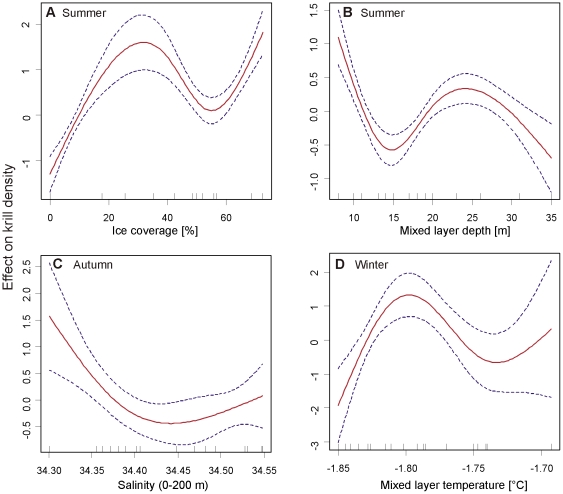

Euphausia superba.Generalized Additive Models of the density of postlarval krill. Effect of additive smoothing functions of (A) proportional ice coverage during SUIT hauls, and (B) mixed layer depth in summer (2007/2008), (C) salinity in the 0–200 m depth layer in autumn (2004), and (D) temperature in the mixed layer in winter (2006) on the fitted density of postlarval krill. Dashed lines show 95% confidence intervals of smoothers.